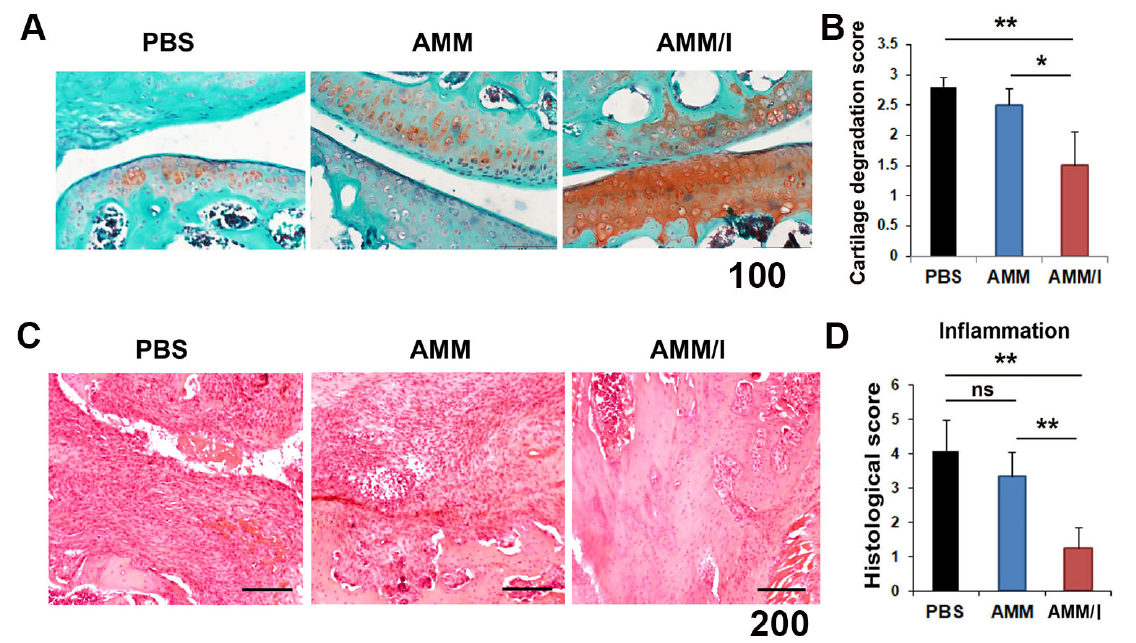
Figure 4. Histological staining of the joints of CIA mice after the injection of cells. ( A ) Proteoglycan expression was determined using safranin O/fast green staining of the joints of CIA mice after cell injection. Bars = 200 µm. ( B ) Quantification of the cartilage degradation score. Loss of proteoglycans was determined by staining the proteoglycans (n = 5 each; * p < 0.05, ** p < 0.01). ( C ) Representative pictures of hematoxylin and eosin (H&E)-stained sections of joint tissues. Bars = 200 µm. ( D ) Quantification of the inflammatory pathological score. Mononuclear cell infiltration and inflammatory pathological scores were measured after cell transplantation. AMM/I-injected tissues showed low mononuclear cell infiltration and a normal cartilage surface morphology (n = 5 each; ** p < 0.01). ns, not significant.